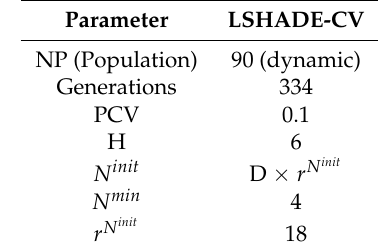
Table 6. Parameters of LSHADE-CV. D is the number of decision variables of the problem, in this case D =